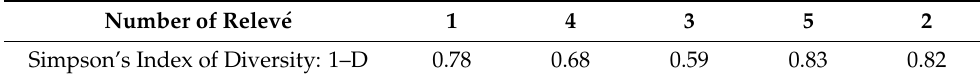
Table 4. Simpson’s Index of Diversity in Fraxino-Alnetum